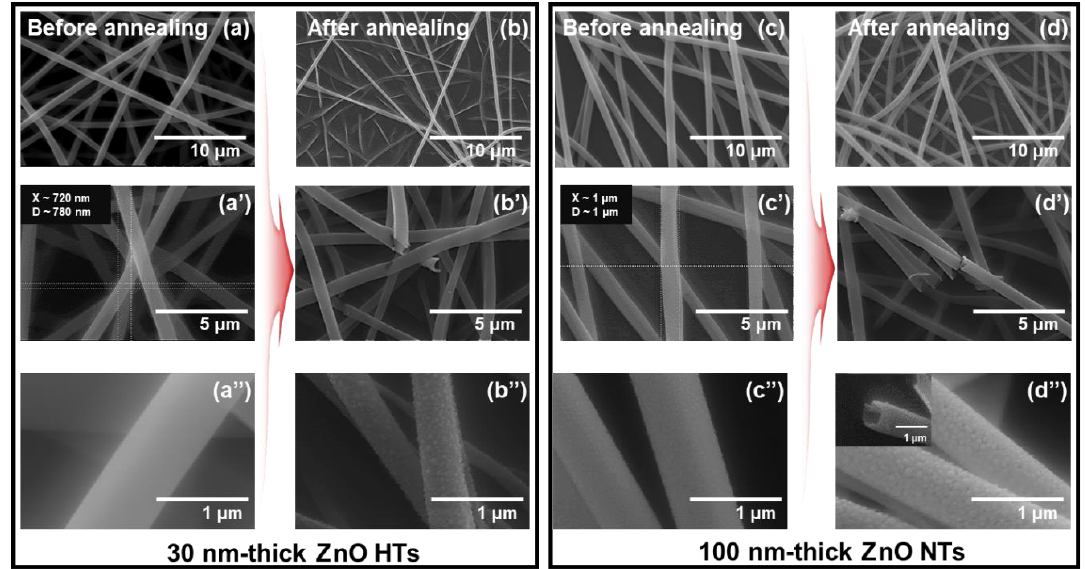
Figure 2. ( a ) FE-SEM image of 30 nm ZnO layer with 10 nm Ti layer (before annealing) on the polyvinylpyrrolidone (PVP) nanowires (NWs), ( b ) ZnO HTs and NTs covered with TiO 2 NPs (after annealing), ( c ) FE-SEM image of 100 nm ZnO layer with 10 nm Ti layer (before annealing) on the PVP NWs, and ( d ) ZnO HTs and NTs covered with TiO 2 NPs (after annealing). ( a’ )–( d’ ) and ( a’’ )–( d’’ ). High magnification images of ( a )–( d ).